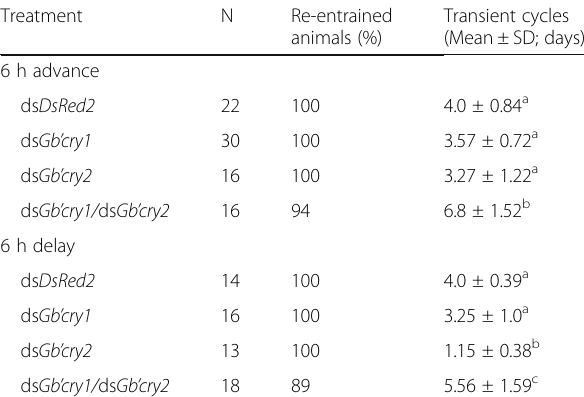
Table 2 Effects of Gb ’ cry1 and Gb ’ cry2 RNAi on re-entrainment of the circadian locomotor rhythms in Gryllus bimaculatus . Different lower case letters indicate that values are significantly different (ANOVA followed by Tukey-test, P < 0.05)